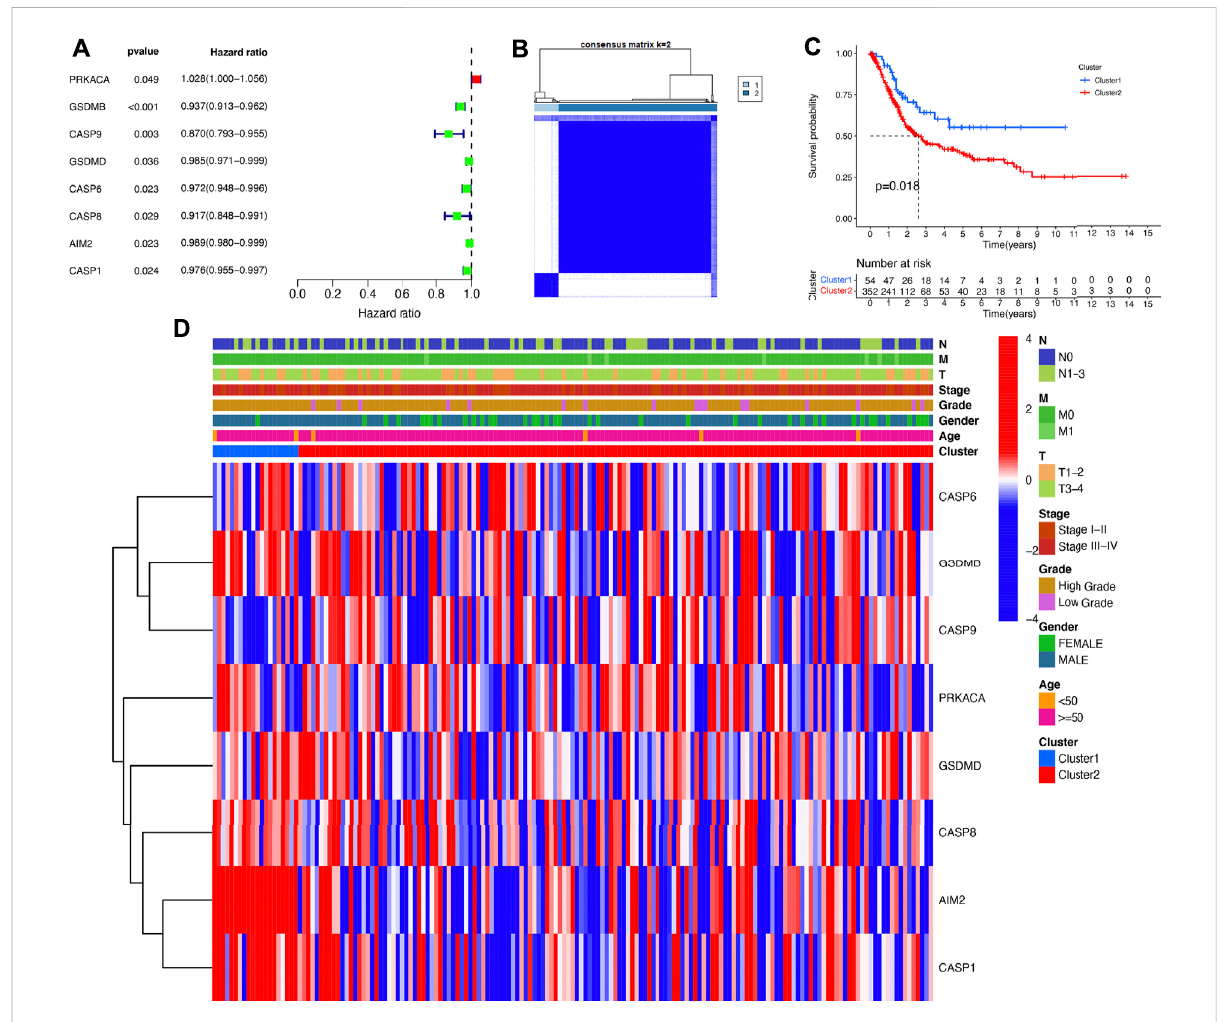
FIGURE 3 Consensus clustering of prognostic PRGs. (A) Univariate Cox regression analysis revealed that eight PRGs (PRKACA, GSDMB, CASP9, GSDMD, CASP6, CASP8, AIM2, and CASP1) were markedly correlated with the prognosis in bladder cancer. (B) Bladder cancer cases were divided into two clusters based on the consensus clustering matrix (k = 2). (C) Overall survival curve of bladder cancer patients in two clusters. (D) The difference of clinicopathological characteristics and gene expression in two